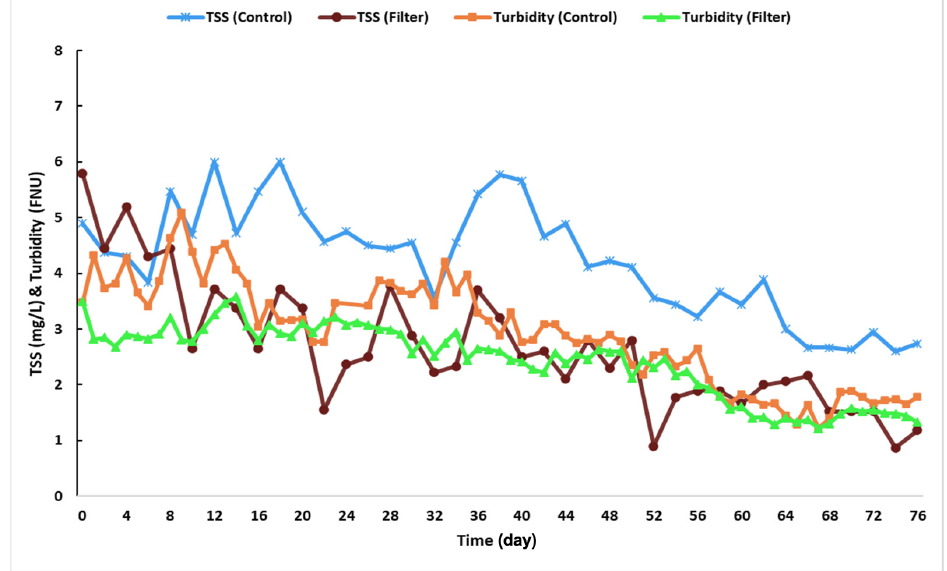
Figure 11. Turbidity (FNU) and total suspended solids concentrations (mg/L) for the 2020 summer in situ experiment.